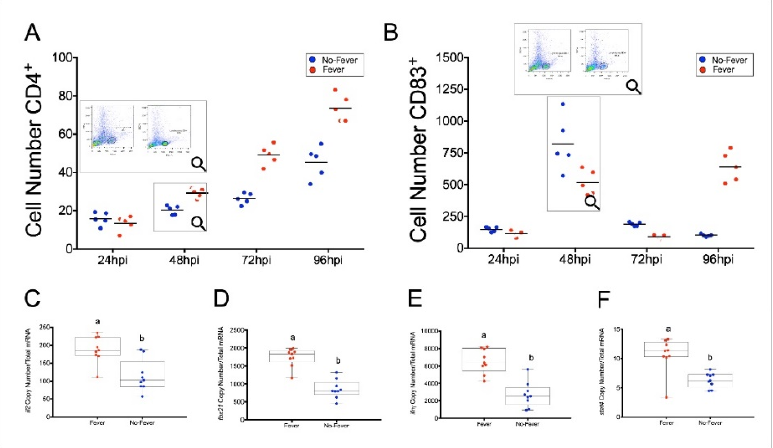
Figure 8. Behavioural fever promotes immune response activation by increasing spleen CD4+ T cell number and lymphocyte-related immune gene expression. ( A ) Spleen-derived lymphocyte population of CD4+T cells (number of cells positive immunodetected with the CD4-BV421 antibody) in no-fever (blue circles) and fever individuals (red circles). The subpanel shows that at 48 hpi, individuals displaying behavioural fever exhibit higher proportions of CD4+ T cells in the spleen ( p = 0.031, n = 60; y axis shows the T cells populations after IPNV challenge and the number of positive cells iden- tified by the CD4-BV421 antibody. ( B ) Number of CD83+ positive cells (number of positive cells detected by the CD83-BV421 antibody) in the spleen of viral-infected individuals. No-fever (blue circles) and fever (red circles) fish are shown. The subpanel shows that, at 48 hpi, the no-fever indi- viduals exhibit a higher number of CD83+ positive cells ( p = 0.031, n = 60; y axis shows the percentage of T cell populations after IPNV challenge. Flow cytometry plots illustrating the cell populations of interest (delineated by black lines) are shown as inserts. ( C – F ) Expression profiles among lympho- cyte-related immune genes detected at 24 hpi. Box plots show the analysis of il2 ( C ) , tbx21 (D) , ifnγ ( E ) , and stat4 ( F ) transcripts abundance in response to thermal treatments. The mean and standard error (SD) value for the copy number of lymphocyte-related transcripts per ng of total RNA is shown. Different letters denote significant differences between fever (red squares) and no-fever